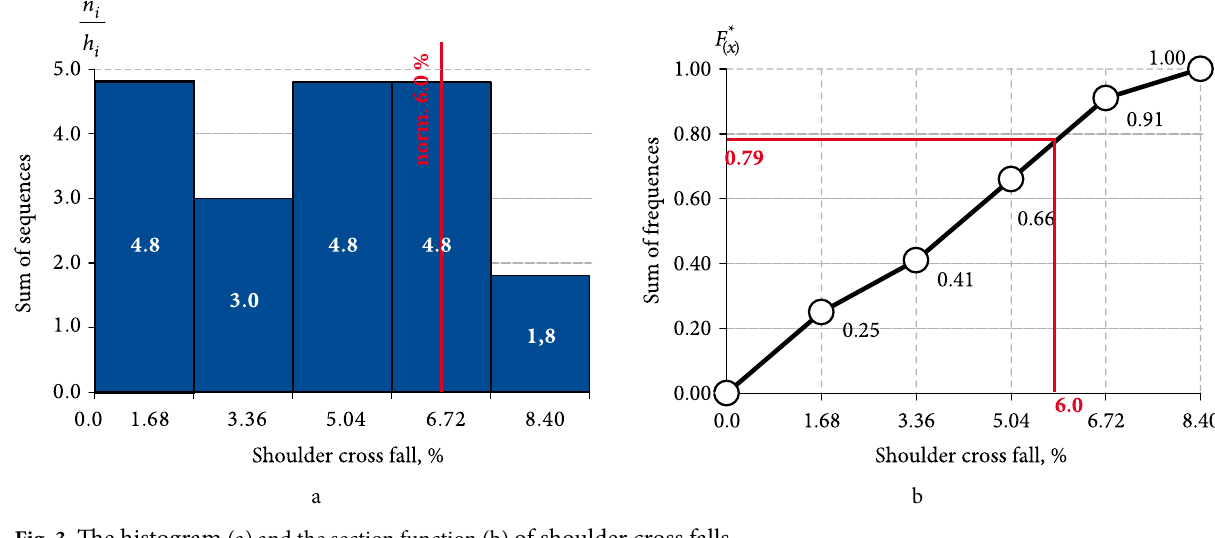
a b fig. 3. The histogram (a) and the section function (b) of shoulder cross falls